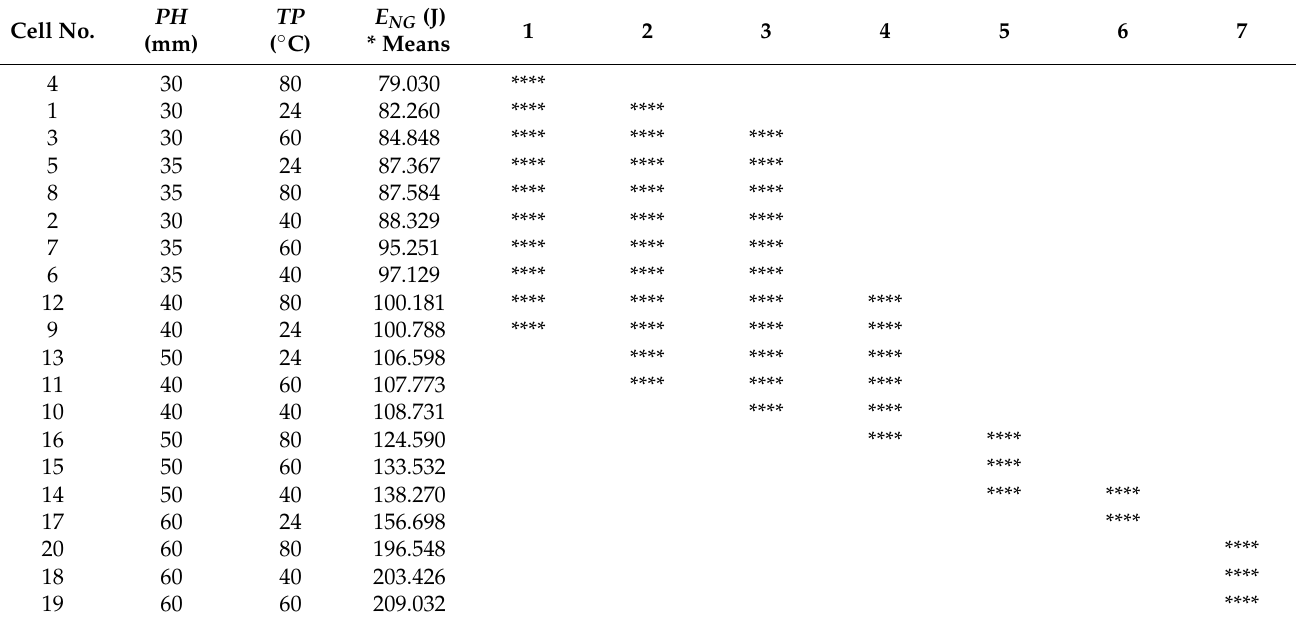
Table 5. Duncan test of homogenous means of the calculated parameter E NG : energy (J) for PH and TP interactions.